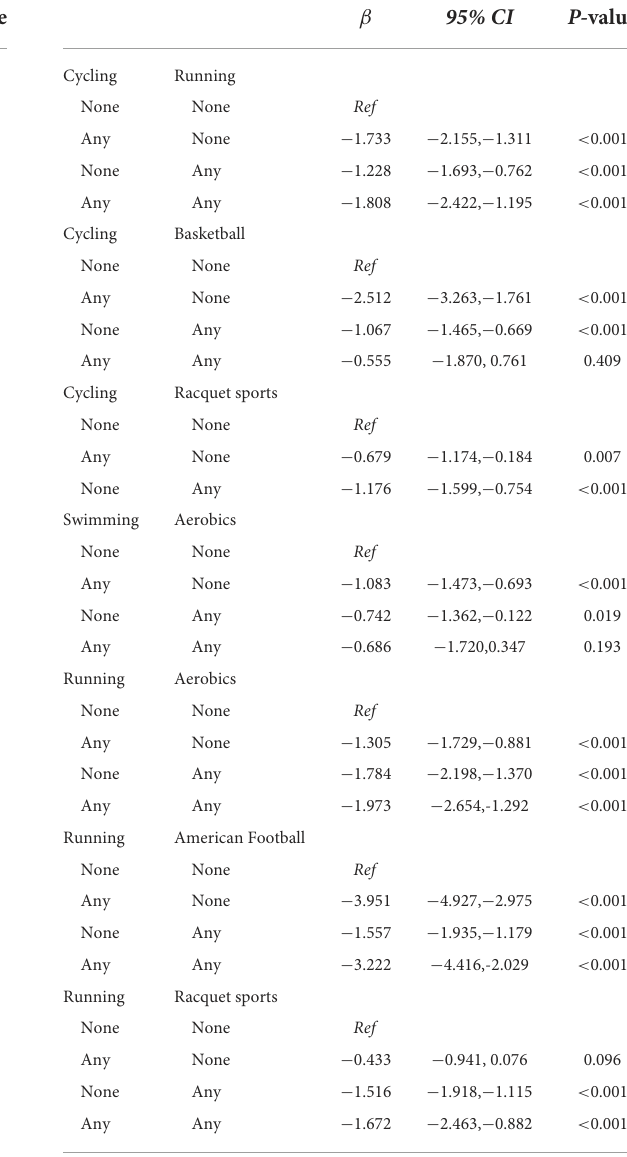
TABLE 6 The interactions between different types of physical activities on CVD risk in adults aged ≥ 30 years *